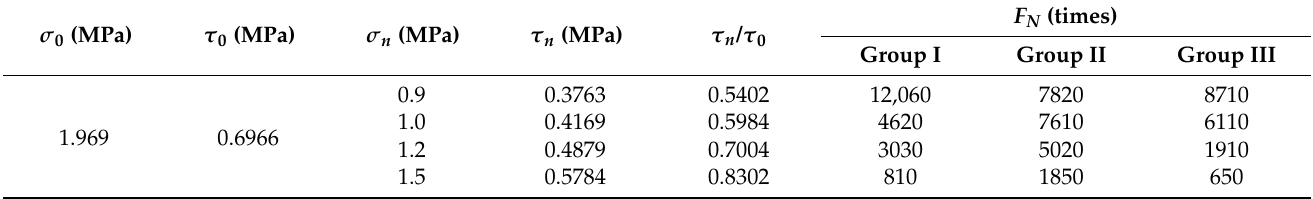
Table 3. F N of fiber asphalt mixture under the 138 kPa confining